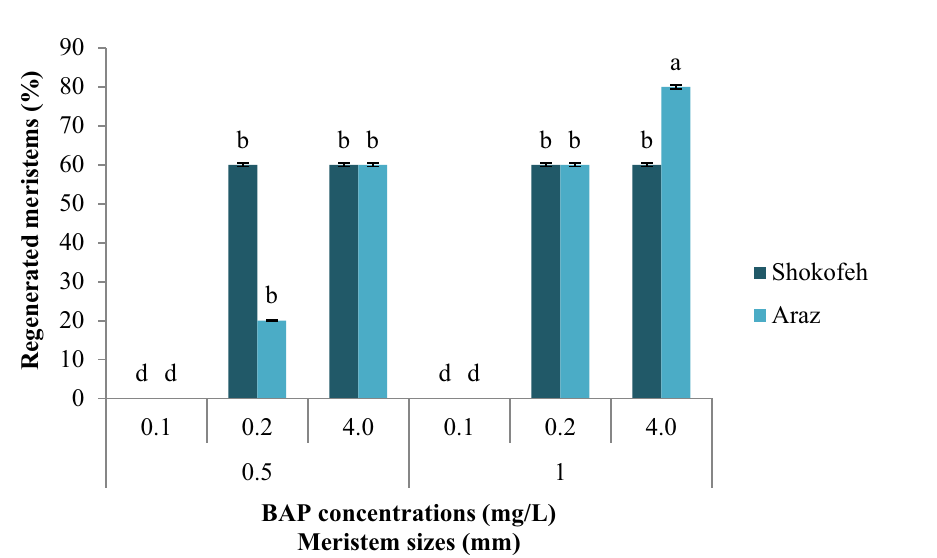
Figure 3. Interaction effects of 2 cultivars × 2 sizes of meristem × 3 hormonal combinations on the percentage of regenerated meristems. (n = 4, p < 0.01, ±